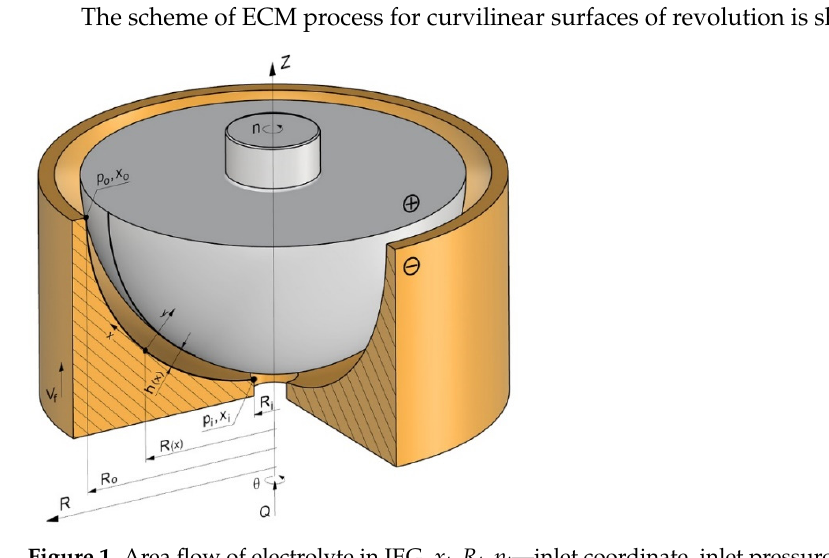
Figure 1. Area flow of electrolyte in IEG. x i , R i , p i —inlet coordinate, inlet pressure, x o , R o , p o —outlet coordinate, outlet pressure, h(x)—interelectrode gap, V f —feed of the TE, Q—flow rate, n —rotation speed of the WP.